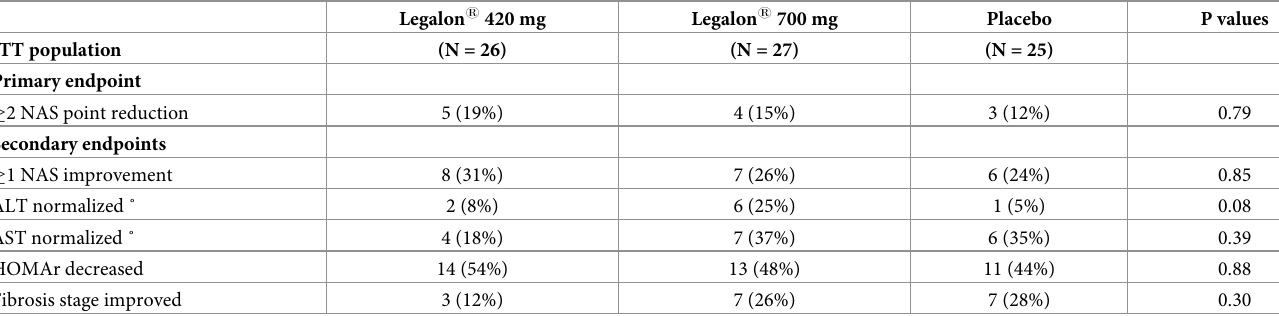
Table 2. Analysis of primary and secondary efficacy outcome measures.